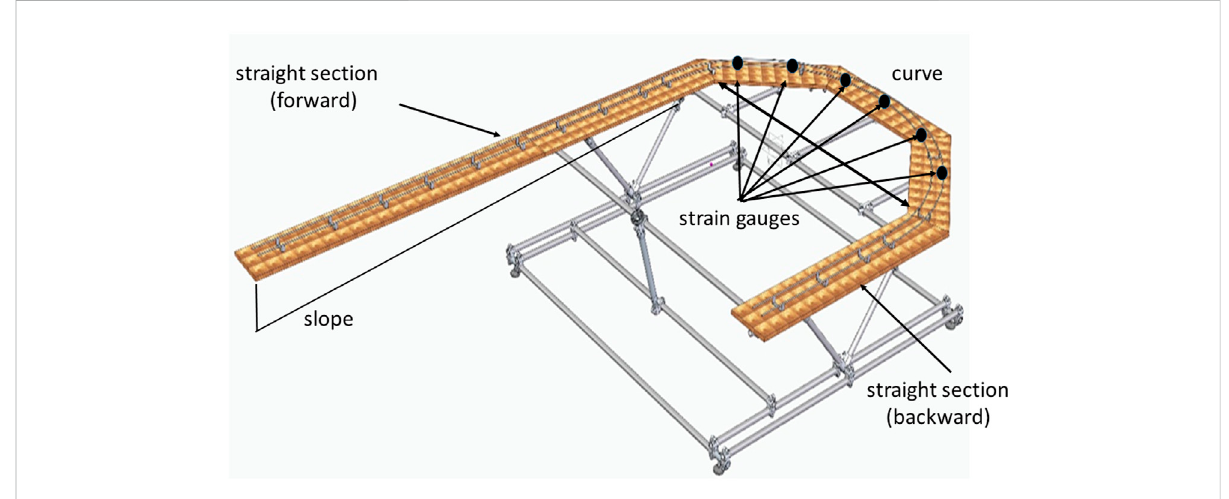
FIGURE 1 Sketch representing the track and the support structure.